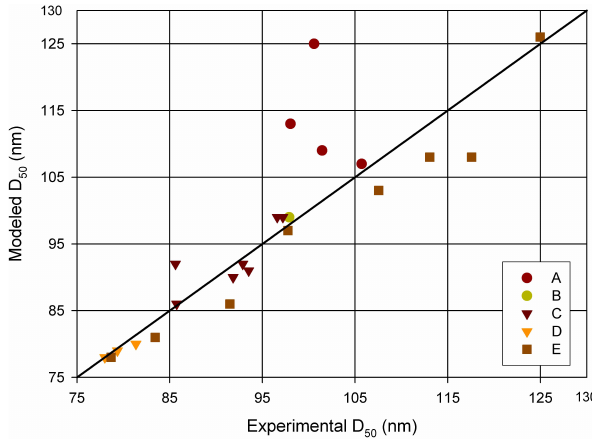
Fig. 7. Same as Fig. 5 but for the diameter D 50 . Table 3. Summary of the modeling results for each cloud case. Numbers shown are the average values. Here the σ(V ) is the stan- dard deviation of the updraft velocity. No standard deviation is given for the event B as it covered only a single averaging